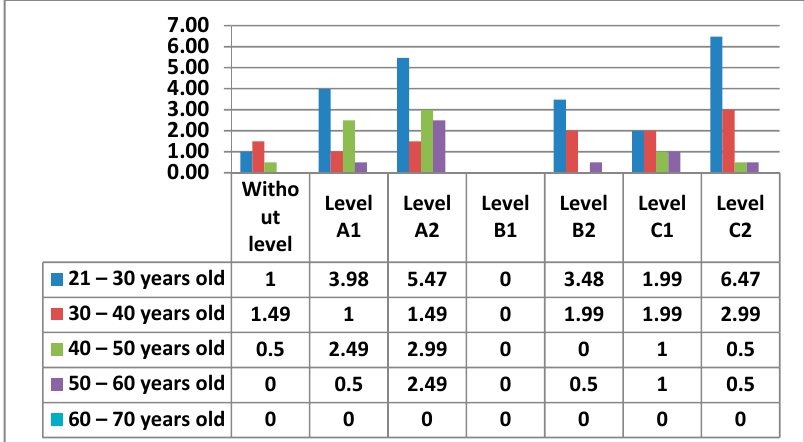
Figure 15. Level of digital competence in teachers by age in area 2.